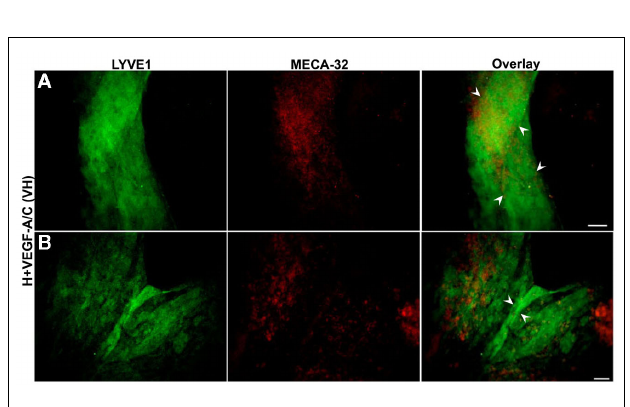
FIGURE 7 | Double immunofluorescent staining of E36.5-day-old hypoxic EBs grown on collagen-I coverslips and treated with VEGF-A/C. Representative images from three different experiments sets for each marker genes are shown. (A,B) Collagen-I promotes predominantly the organization of LYVE1 positive lymphatic vessel-like structures (marked by arrowheads) when stimulated under hypoxic andVEGF-A/C environments.There are some traces of MECA-32 positive BECs along with these lymphatic vessel-like structures. Unlike E22.5-day-old EBs, all four types of treatment at E36.5 failed to form organized blood vessel-like structures. Images were taken at 40 × magnification (scale bar 30 μ m).